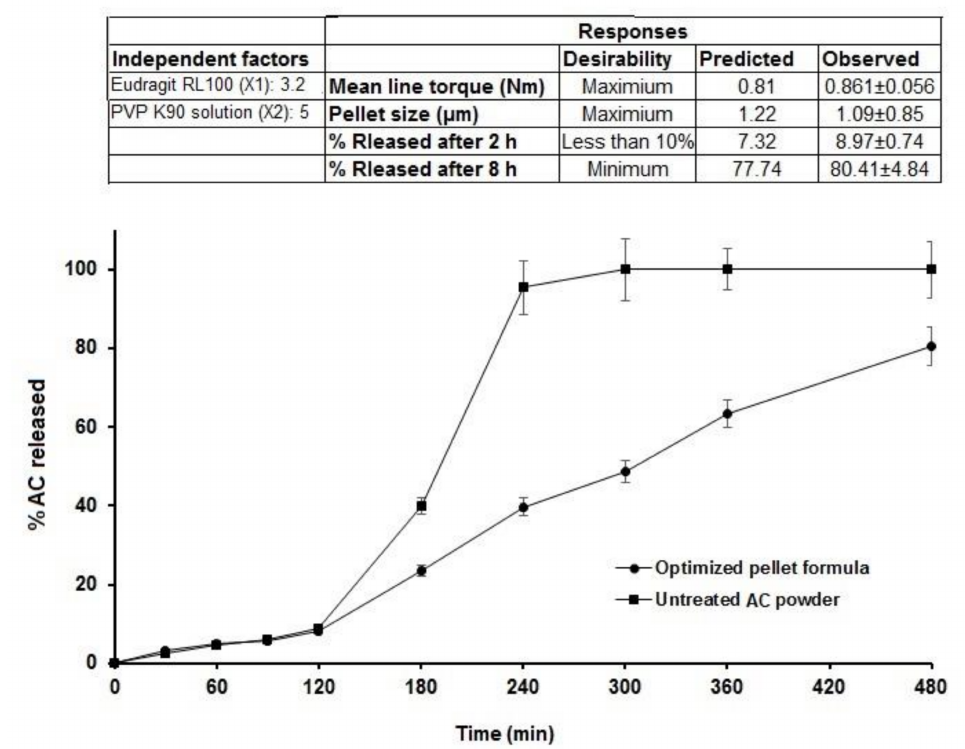
Figure 6. In vitro release profiles of AC from the optimized sustained-release matrix pellet formula in comparison to the untreated drug (the enclosed figure refers to the predicted and observed response values of the optimized pellet